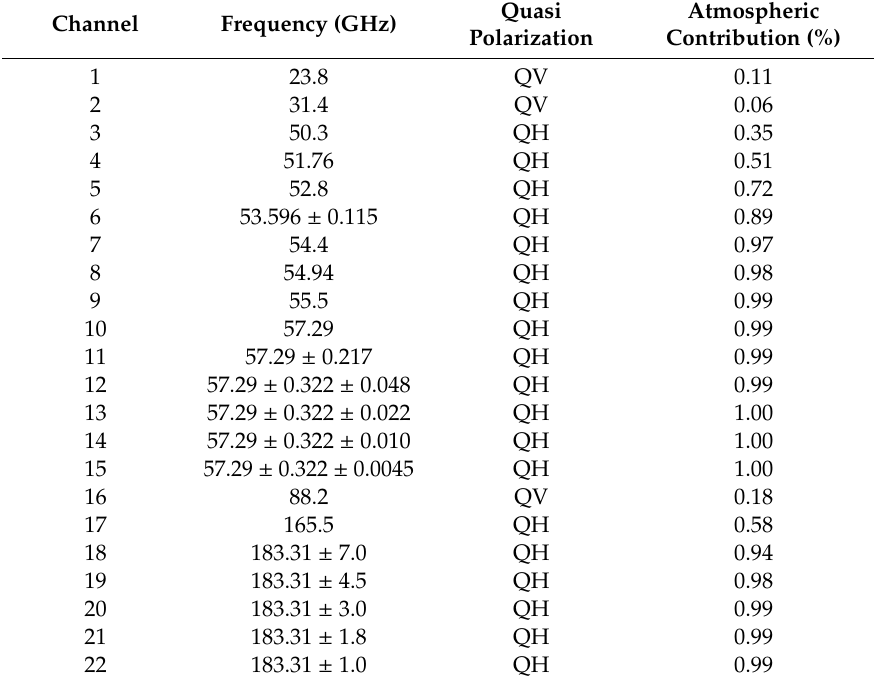
Table 1. Channel characteristics of Advanced Technology Microwave Sounder